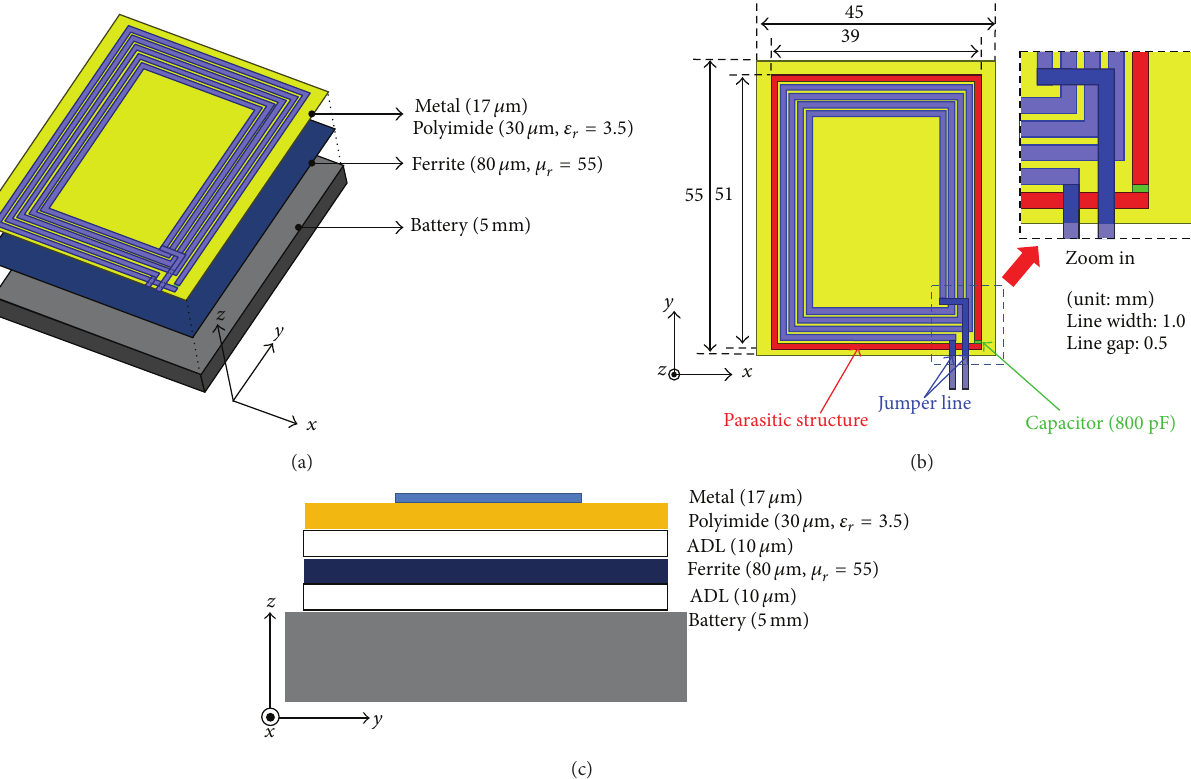
Figure 1: Geometry of the proposed NFC loop antenna; (a) overall view, (b) top view printed on FPCB, and (c) side